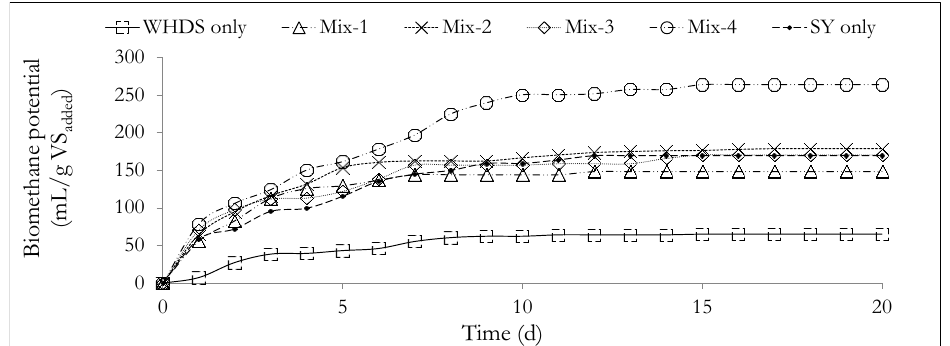
Figure 4. The variation of cumulative biomethane potential with time from the different substrate mixtures. The mass ratios of the volatile solids of WHDS to the volatile solids of SY for the different substrate mixtures are listed in Table 3.